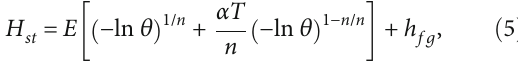
isotherm. (b) PSD of zeolite 2